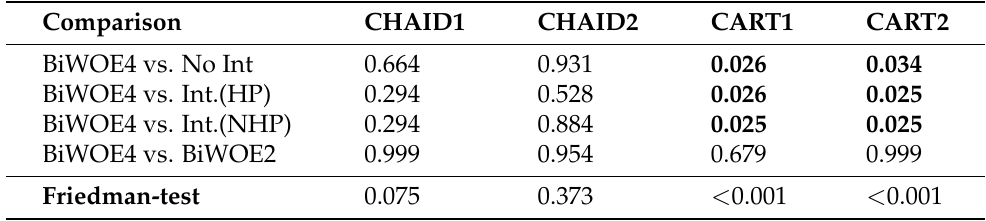
Table 10. Results of non-parametric tests. Holm test p -values of the pairwise comparisons (for each combination of tree growing algorithm and depth) are given at the four middle rows. Friedman test p -values for multiple comparisons are given in the last